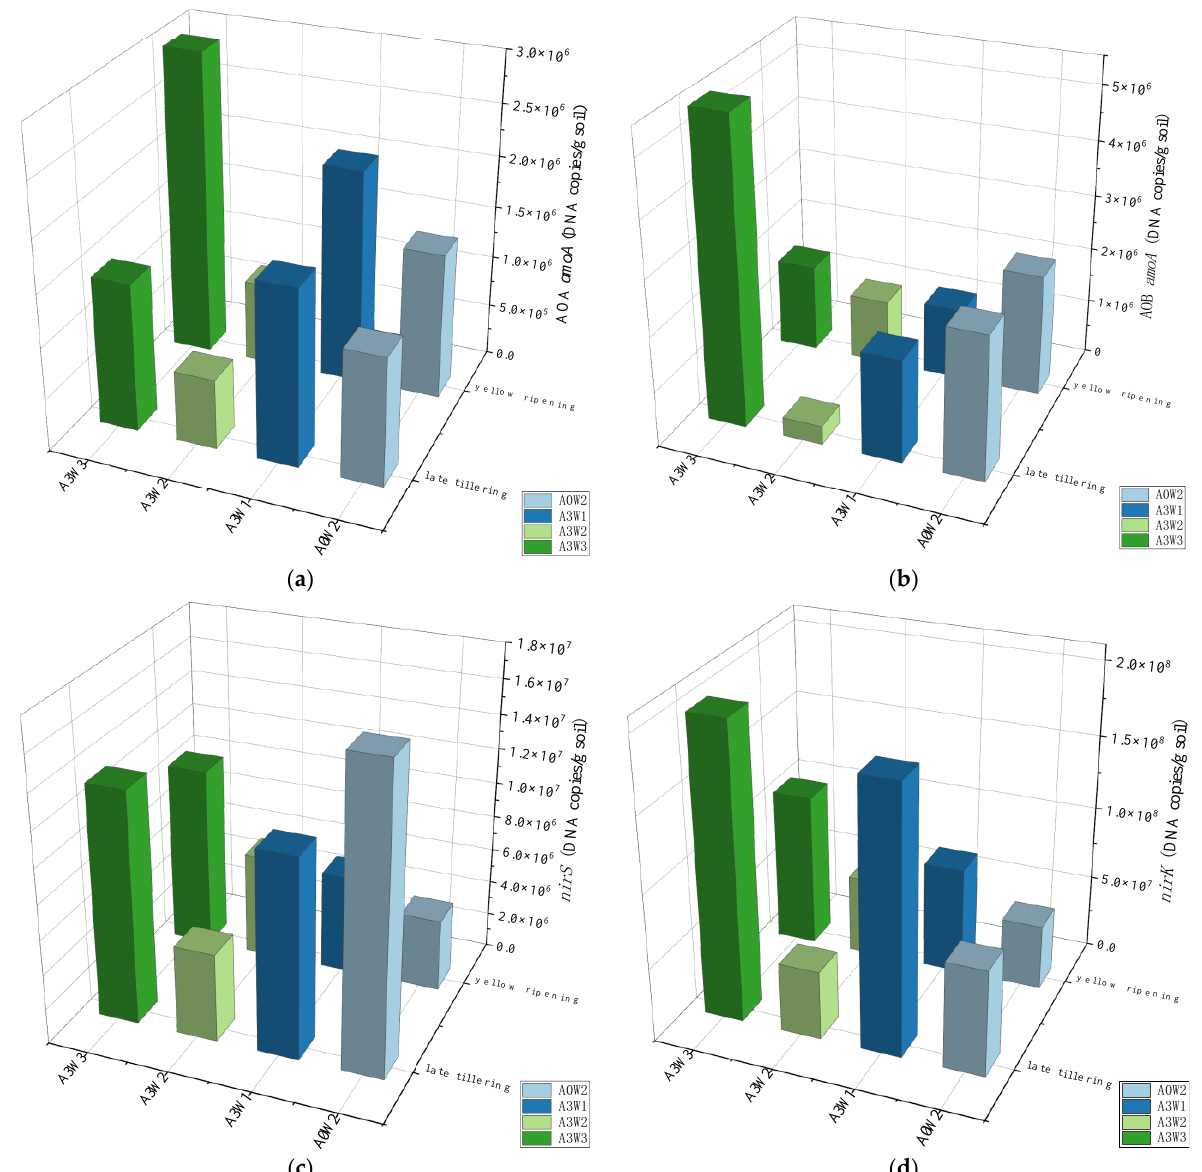
Figure 2. Absolute abundance of AOA amoA ( a ), AOB amoA ( b ), nirS ( c ), and nirK ( d ). A, the concentration gradient of the antibiotic sulfamethazine, including A0 (0 ng·L −1 ), A1 (500 ng·L −1 ), A2 (1500 ng·L −1 ), and A3 (3000 ng·L −1 ). W, irrigation methods, including W1 (flood irrigation), W2 (mild AWD), and W3 (severe AWD).